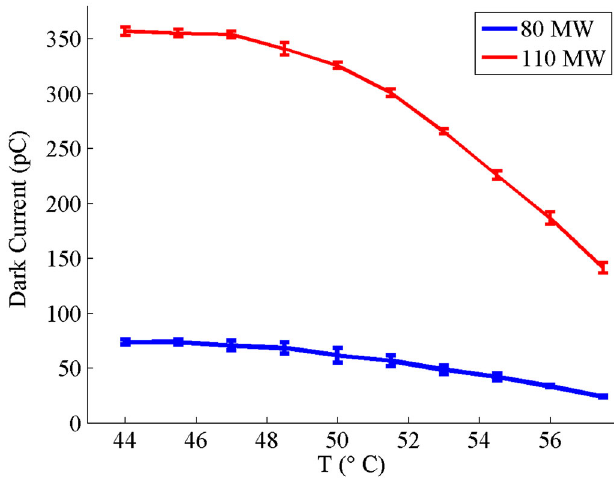
FIG. 11. Integrated dark current as a function of cathode gradient with 147 ns long rf pulses measured 0.56 m from the cathode.